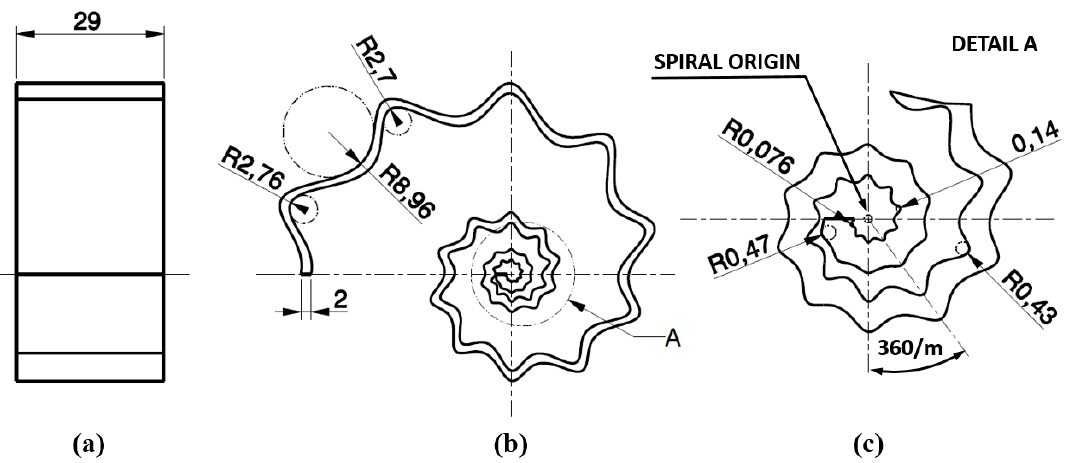
Figure 2. SsDRA Drawings: ( a ) Side view; ( b ) Top view; ( c ) Detailed view of the SsDRA close to the antenna origin. Units: mm and degree.